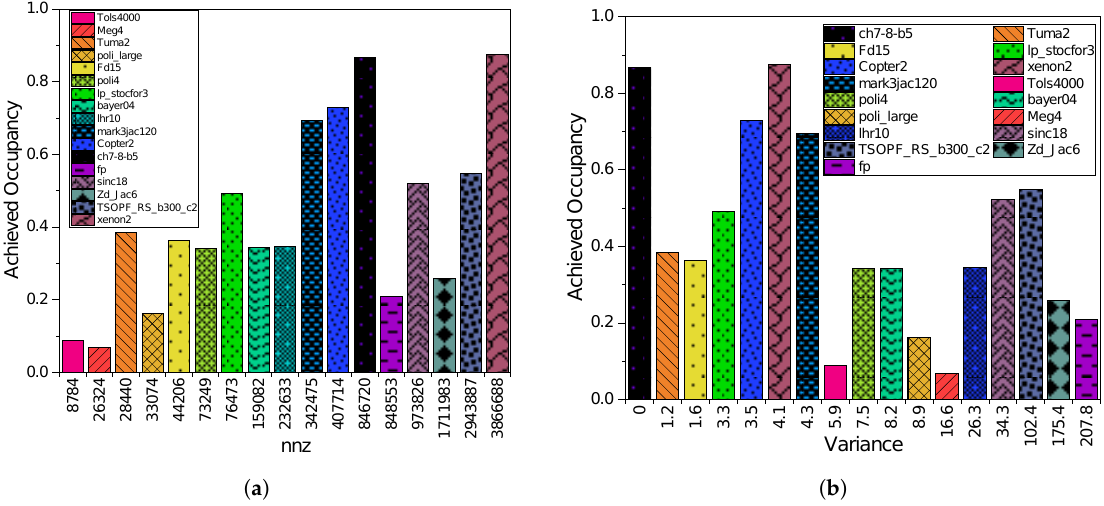
Figure 3. CSR achieved occupancy against: ( a ) nnz and ( b ) npr variance